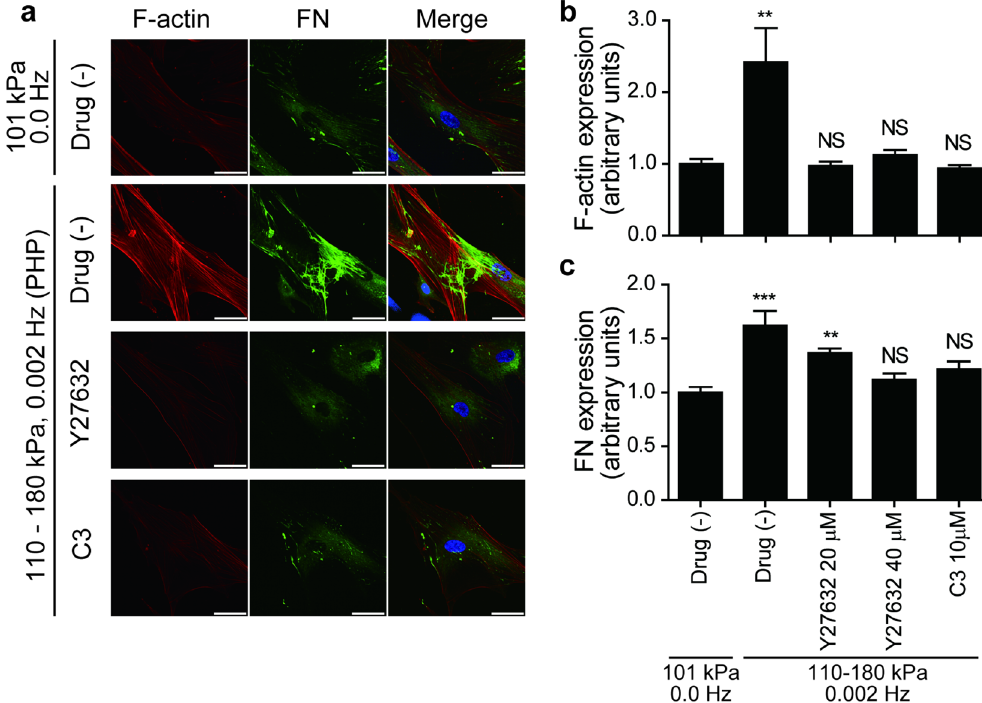
Figure 3. The effect of Rho kinase inhibition on stress-fiber formation and FN fibrillogenesis. ( a ) Representative images of immunocytochemistry of hUASMCs exposed to PHP (110–180 kPa, 0.002 Hz) for 24 h. Cells were incubated with Y27630 (40 μ mol/L) or C3 (10 μ mol/L) during pressurization and stained for F-actin and FN. Scale bars: 50 μ m. ( b and c ) Quantification of intensity of F-actin and FN of ( a ), respectively. n = 7–11, NS, not significant vs. 101 kPa, 0.0 Hz (atmospheric pressure); ** p < 0.01; *** p < 0.001. Values are shown as the mean ± standard error of the mean (SEM) of independent experiments. Data were analyzed using analysis of variance (ANOVA) followed by Dunnett’s multiple comparison